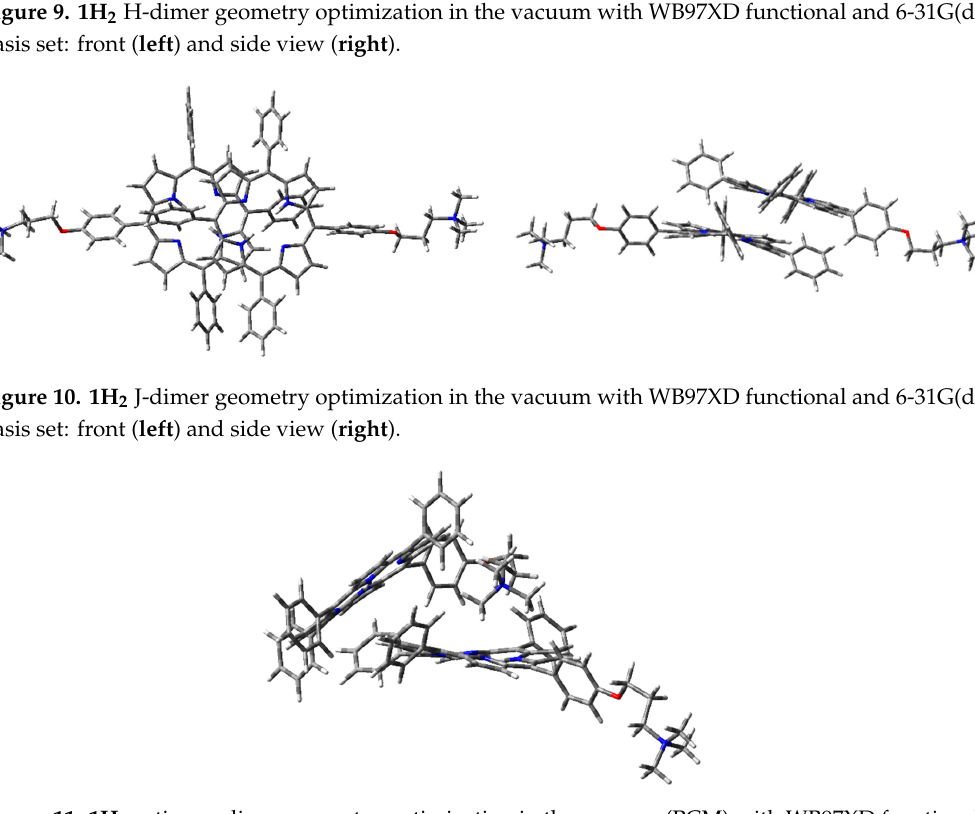
Figure 11. 1H 2 cation– π dimer geometry optimization in the vacuum (PCM) with WB97XD functional and 6-31G(d) basis set.